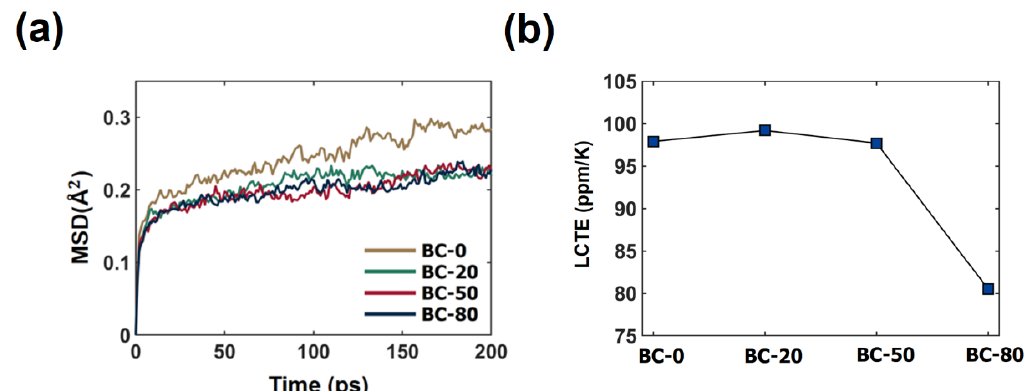
Figure 4. Thermal properties of the PMMA-based BC models. ( a ) MSD and ( b ) LCTE of BCs at 300 K, according to the crosslinking density.